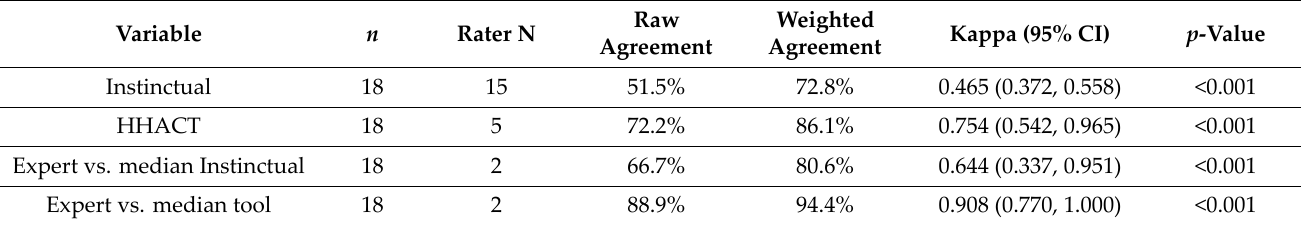
Table 2. Reliability of instinctual and HHACT ratings using Gwets